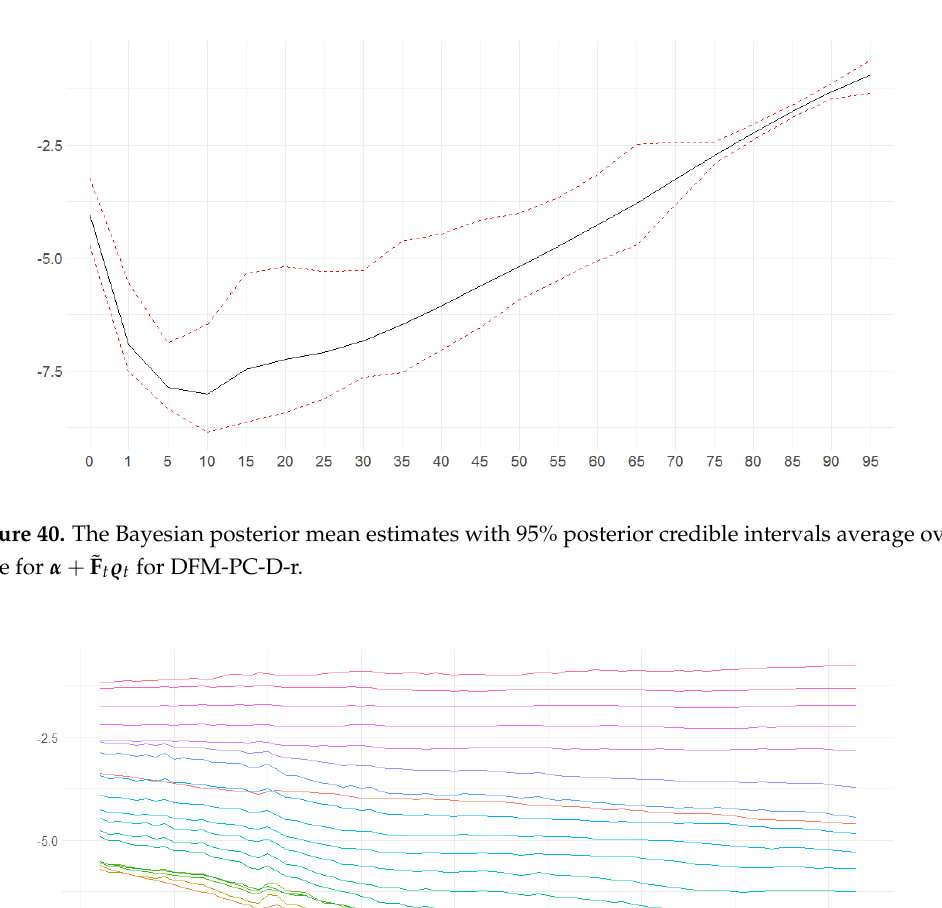
over time for DFM-PC-D-r. Colours of t